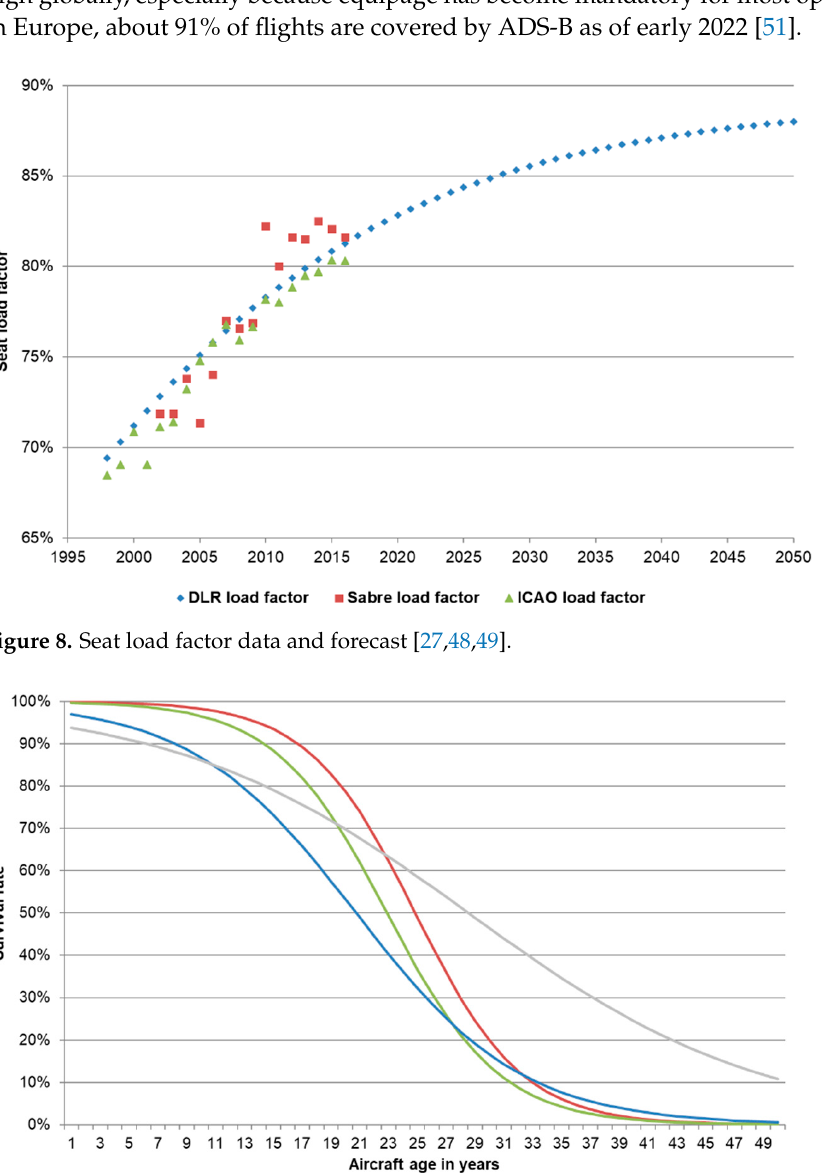
Figure 9. Survival probabilities of aircraft in relation to the aircraft category and age.